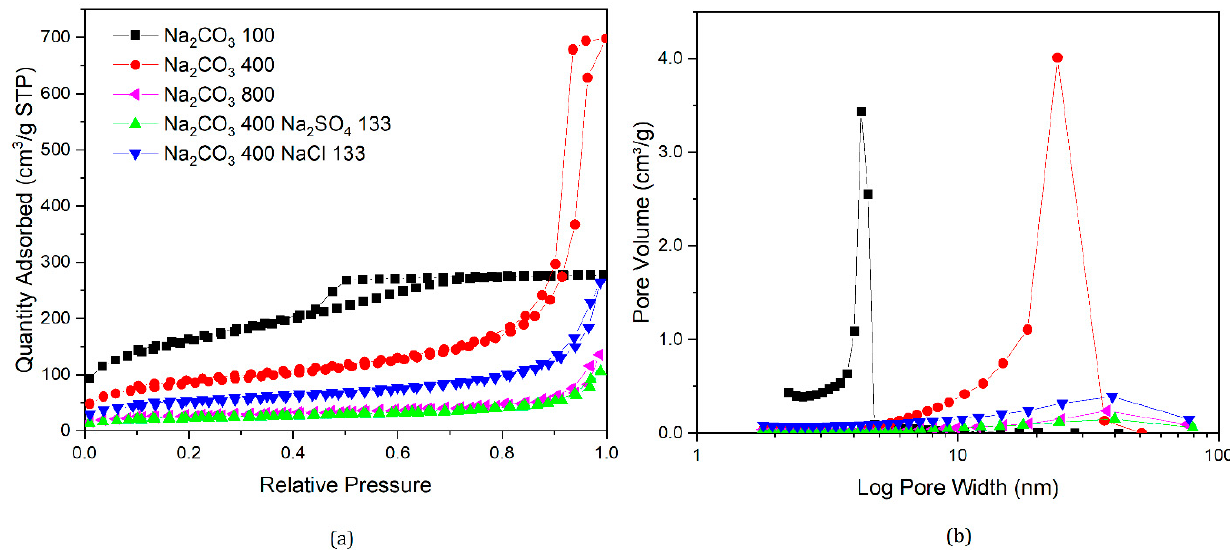
Figure 8. Nitrogen sorption isotherms of gels with modified catalyst composition ( a ) and corresponding pore size distribu- tions ( b ).